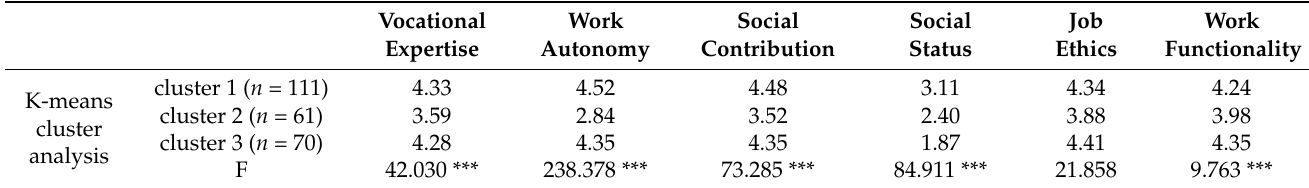
Table 4. Results of Cluster analysis based on Professionalism